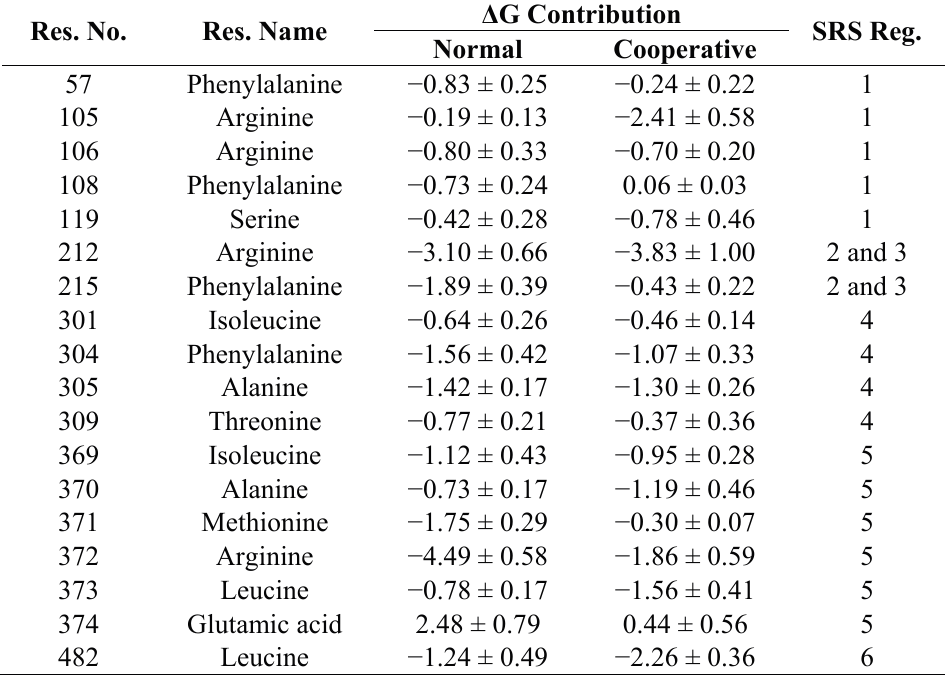
Table 3. Binding free energy decomposition for each residue located in the active pocket of the normal and cooperative binding models constructed based on the crystal structure